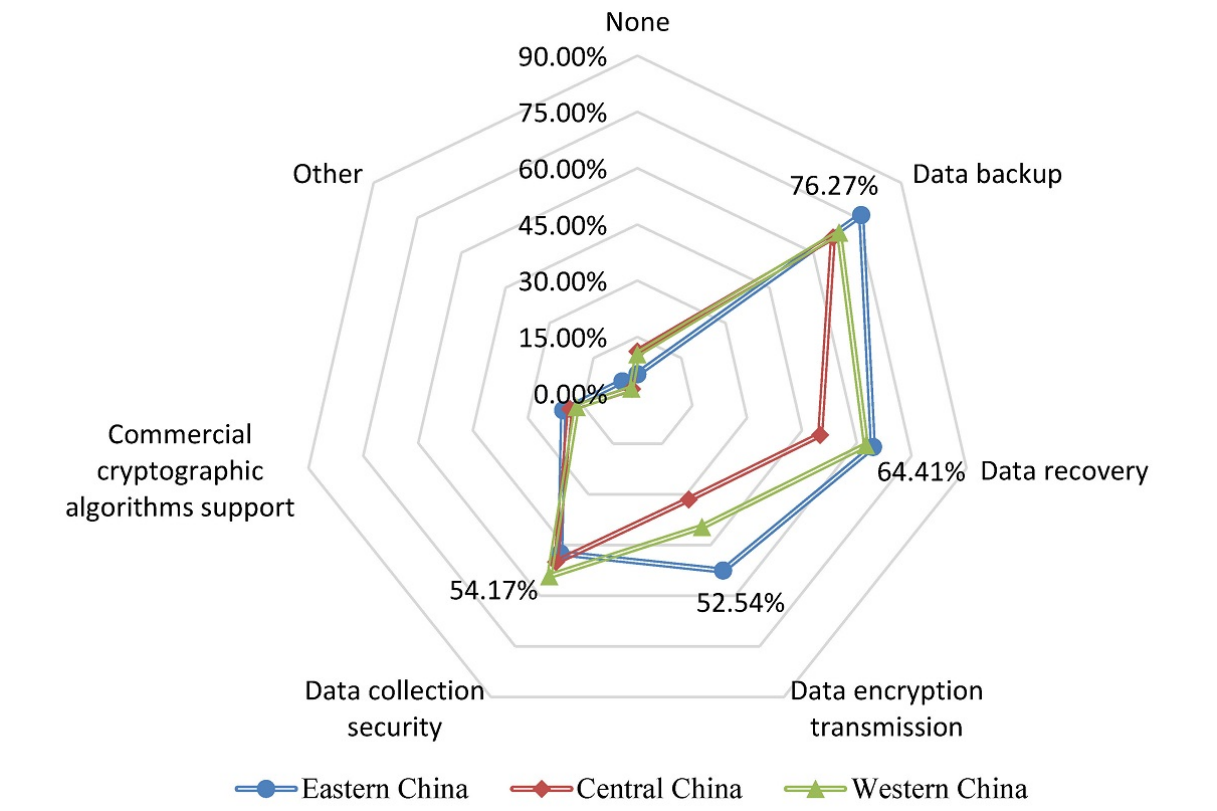
Figure 4. Telemedicine data security measures for tertiary hospitals in different regions of